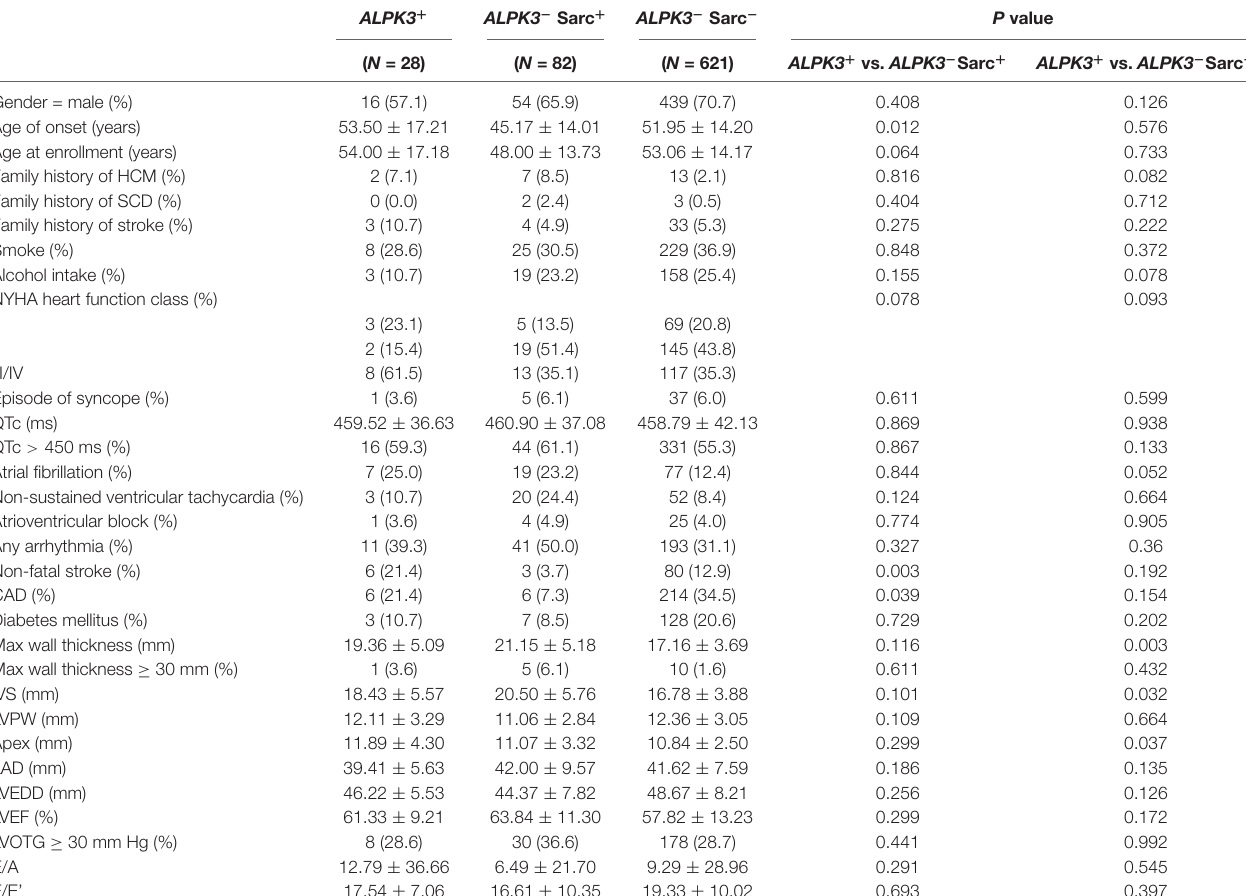
TABLE 1 | Baseline comparisons of ALPK3 carriers, sarcomere-positive, and sarcomere-negative patients. ALPK3 + ALPK3 − Sarc + ALPK3 − Sarc